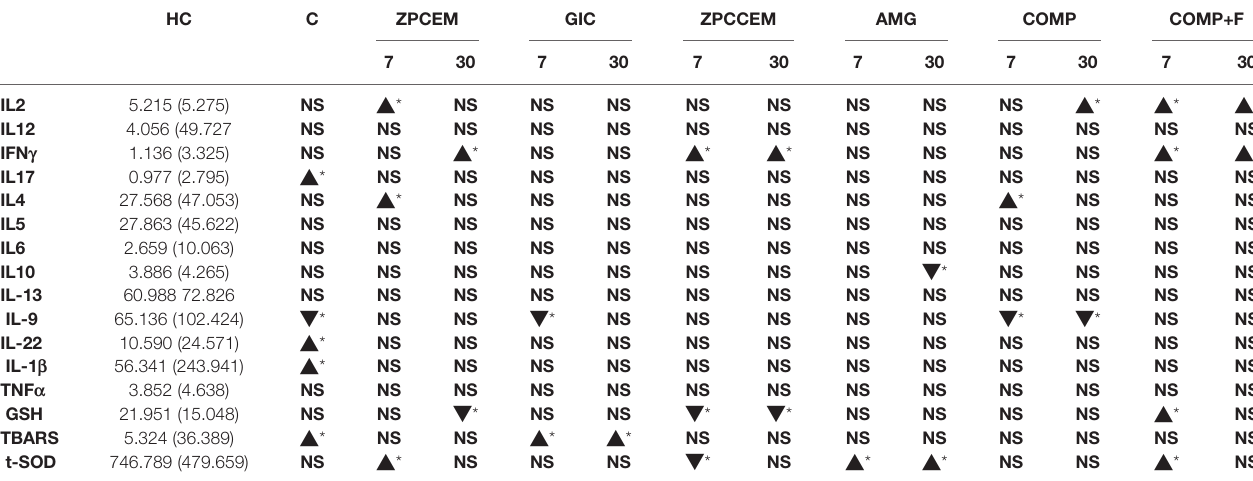
TABLE 2 | Biomarker levels between experimental groups and healthy controls in different